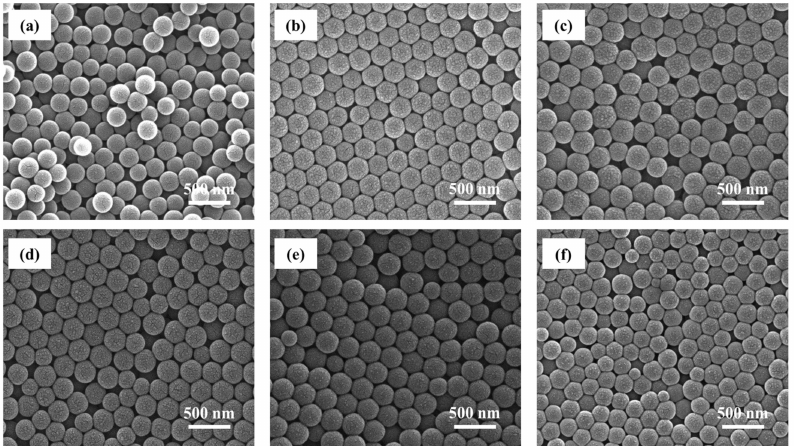
Figure 5. Top view of the morphologies and structures of coatings formed by self-assembly of PSt-based microspheres on a wood surface at 50 ◦ C; ( a ) PSt, ( b ) P(St-AA), ( c ) P(St-MMA-AA), ( d ) P(St- MMA), ( e ) P(St-BA-AA), and ( f )